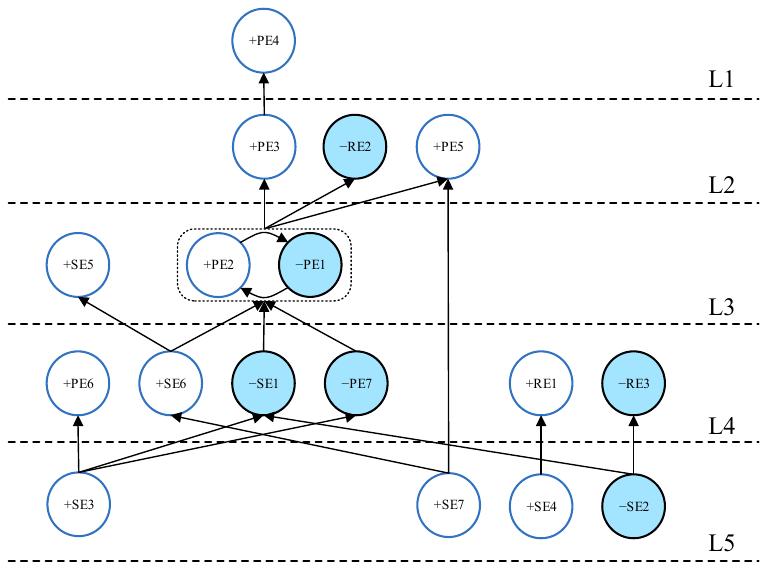
(cid:12) (cid:12) (cid:12) (cid:12) > (cid:12) C ij (cid:12)